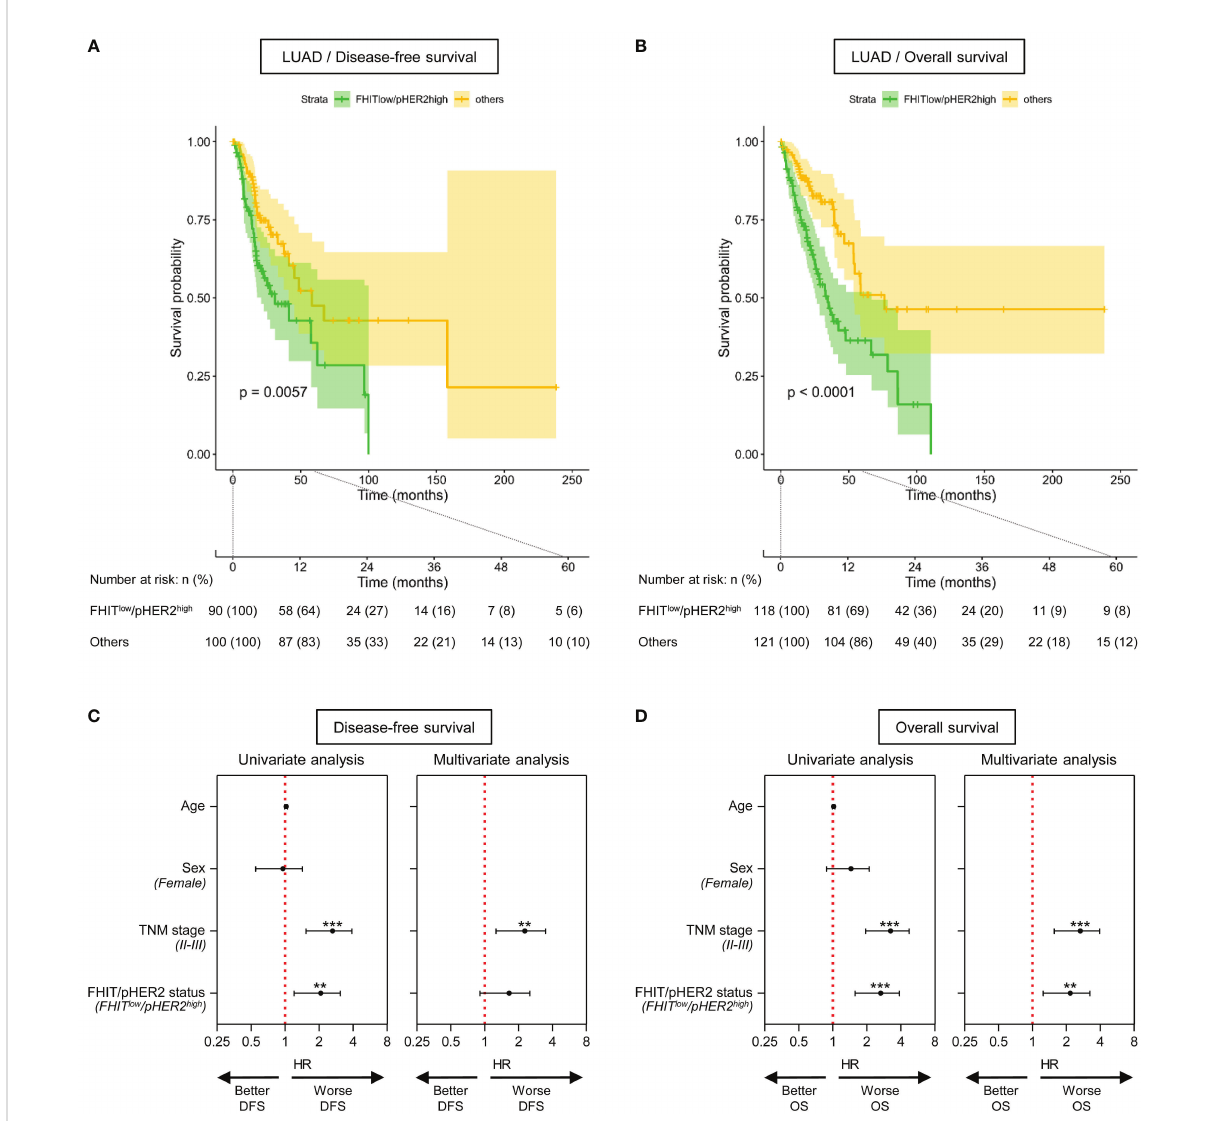
FIGURE 4 The FHIT low /pHER2 high signature predicts a poor outcome in Firehose Legacy TCGA-LUAD cohort. (A, B) Kaplan-Meier survival curves for disease-free survival (A) and overall survival (B) by FHIT/pHER2 status. FHIT low /pHER2 high patients are in green and others in yellow. Each cross is a censored event. Con fi dence intervals for the curves are colored. Numbers at risk are shown by FHIT/pHER2 status every 12 months for 5 years. Log-rank test p-value for the difference between the curves is written. (C, D) Signi fi cant variates for disease-free (DFS) (C) and overall (OS) (D) survival. Female, stages II-III and FHIT low /pHER2 high were compared to their respective reference Male, stage I, and Others. Hazard risk (HR) and it ’ s 95% con fi dence interval (CI) are plotted for all tested variates (Wald statistic p-value). The red vertical dashed line corresponds to HR of 1. **p < 0.01; ***p <